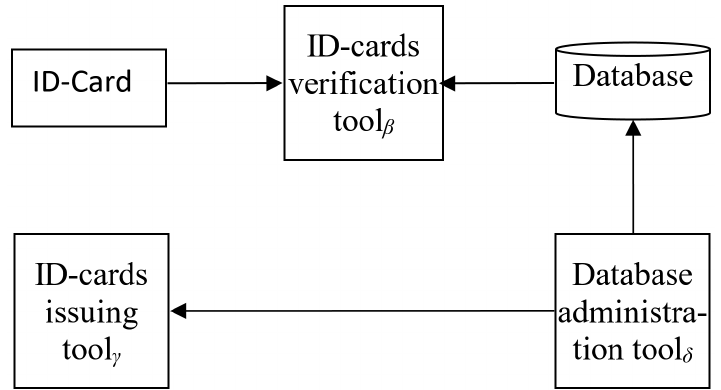
Figure 1. The schematic representation of the ID-card verification and issuing